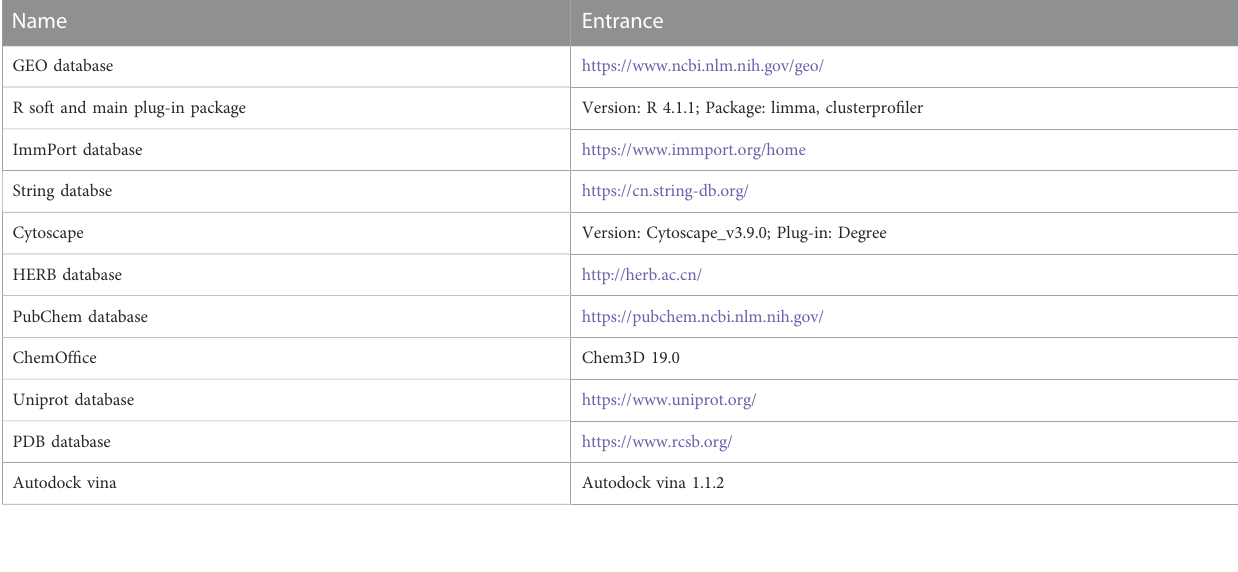
TABLE 2 Herbal medicines predicted on the basis of key genes. Key genes